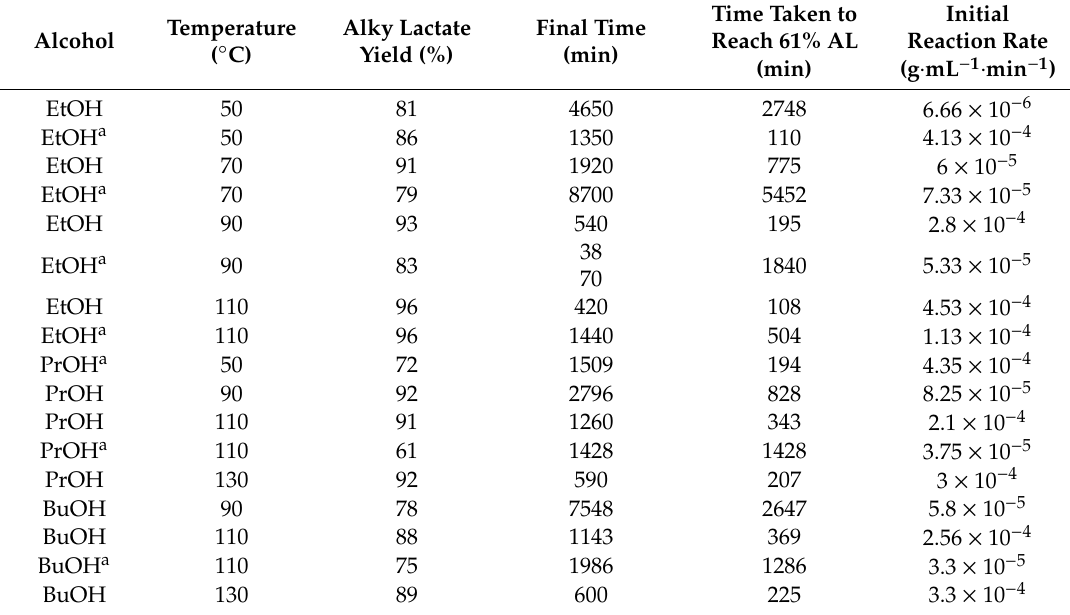
Table 1. Time taken to reach high AL yield for di ff erent alcohols at di ff erent